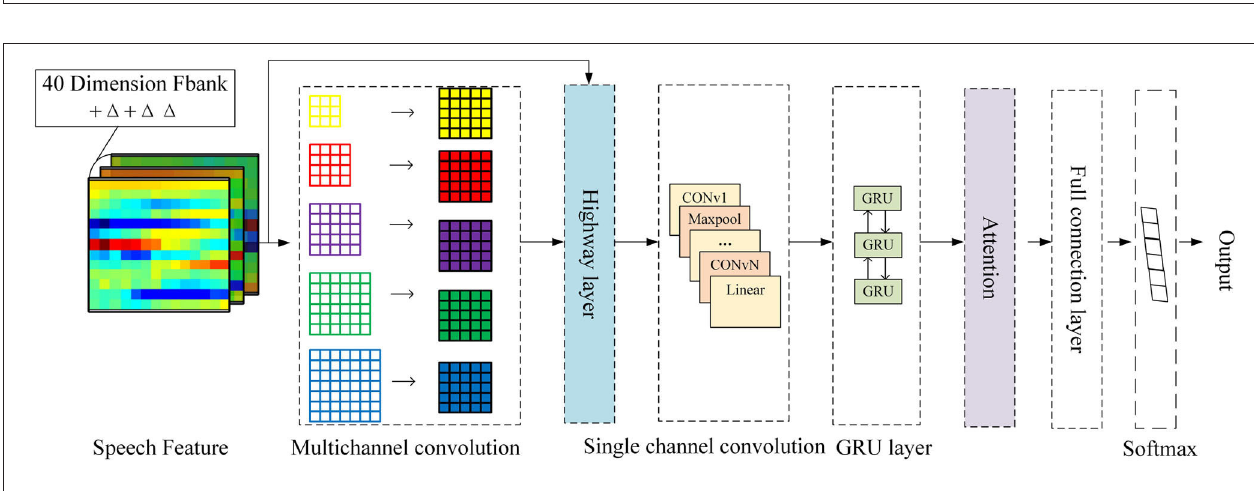
FIGURE 8 | 3D-CBHGA